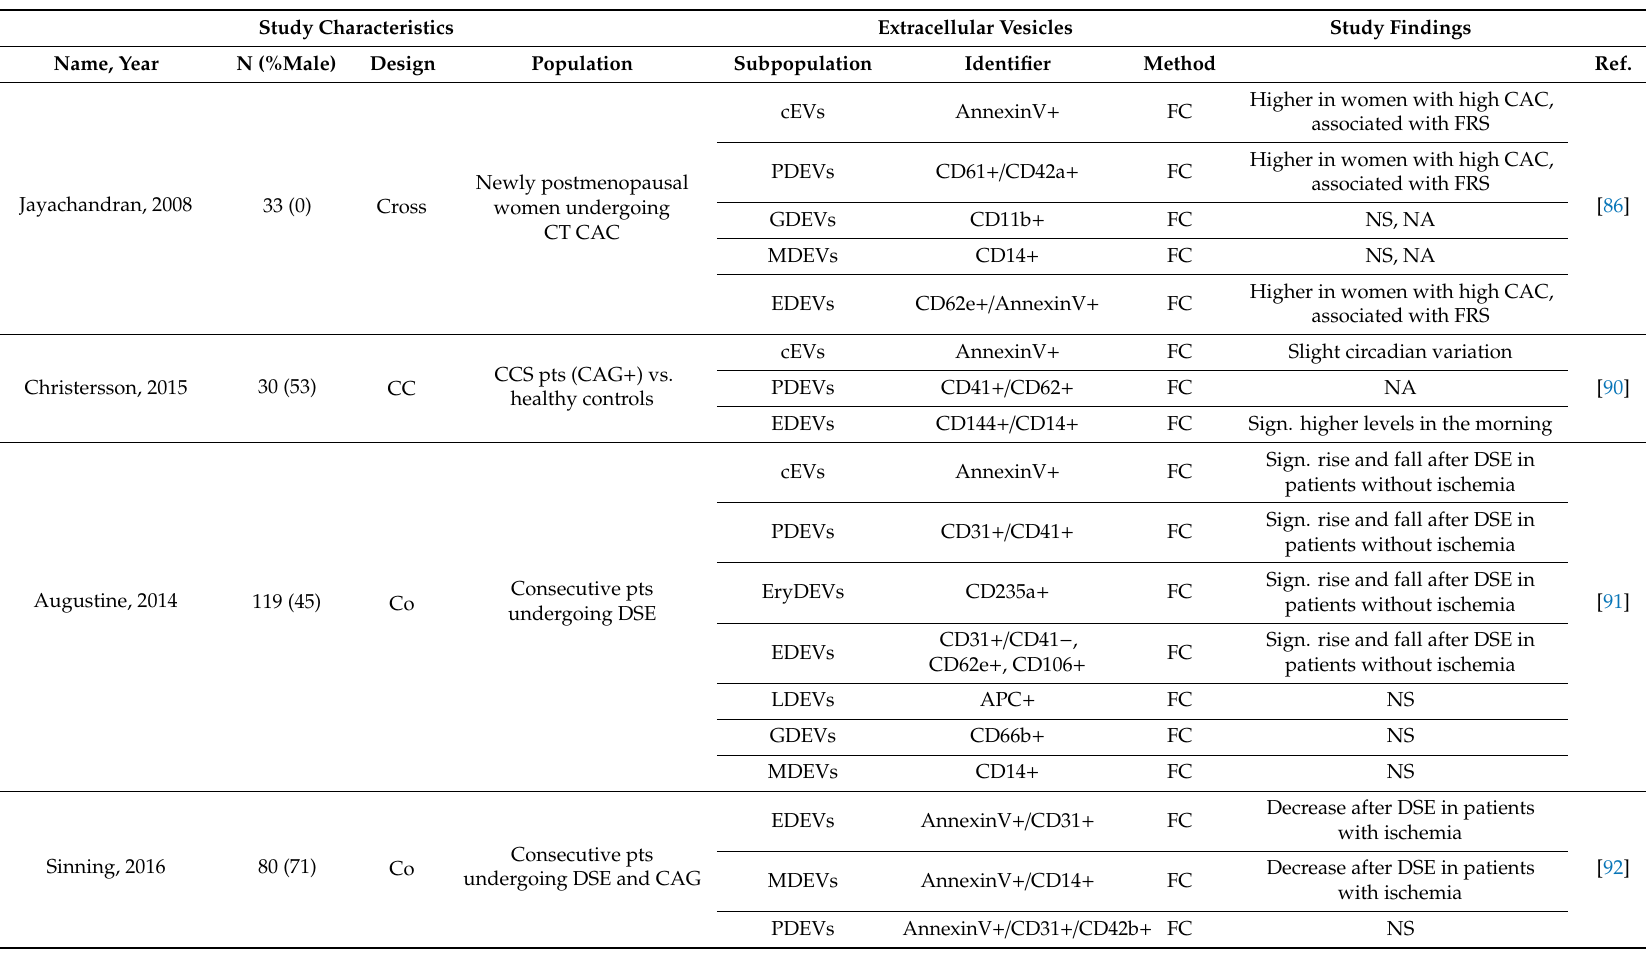
Table 1. Overview of preselected publications on extracellular vesicle count in chronic coronary syndrome patients, including details on